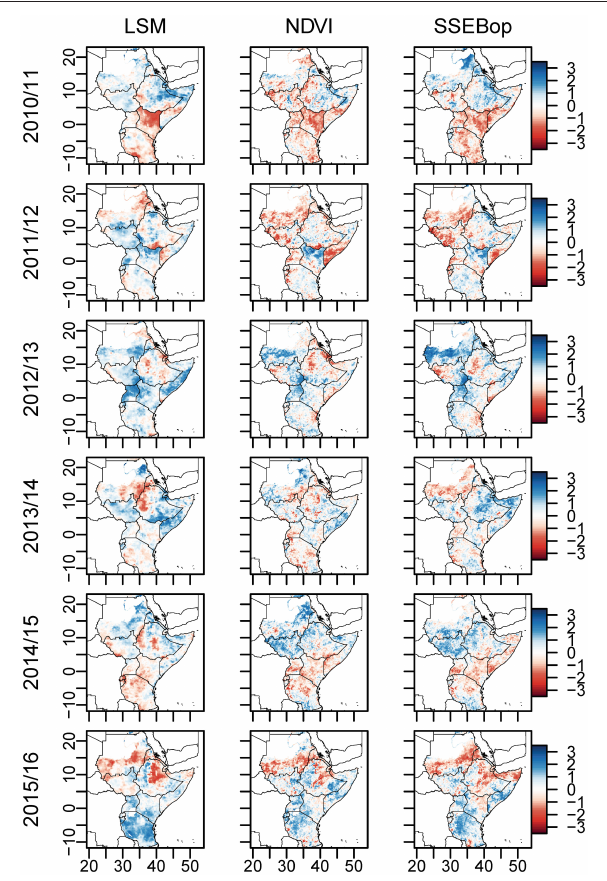
FIGURE 4 | Standardized anomaly composites of LSM ET, NDVI, and SSEBop ET over the wetter half of the year for the period